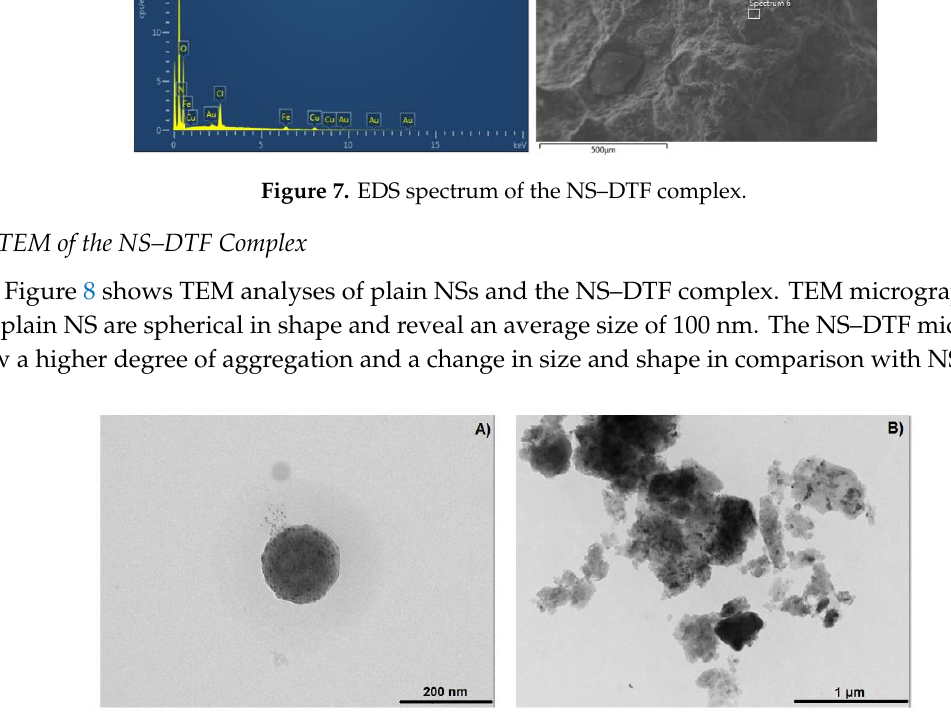
Figure 8. TEM analysis of: NSs ( A ) and the NS–DTF inclusion compound ( B ).